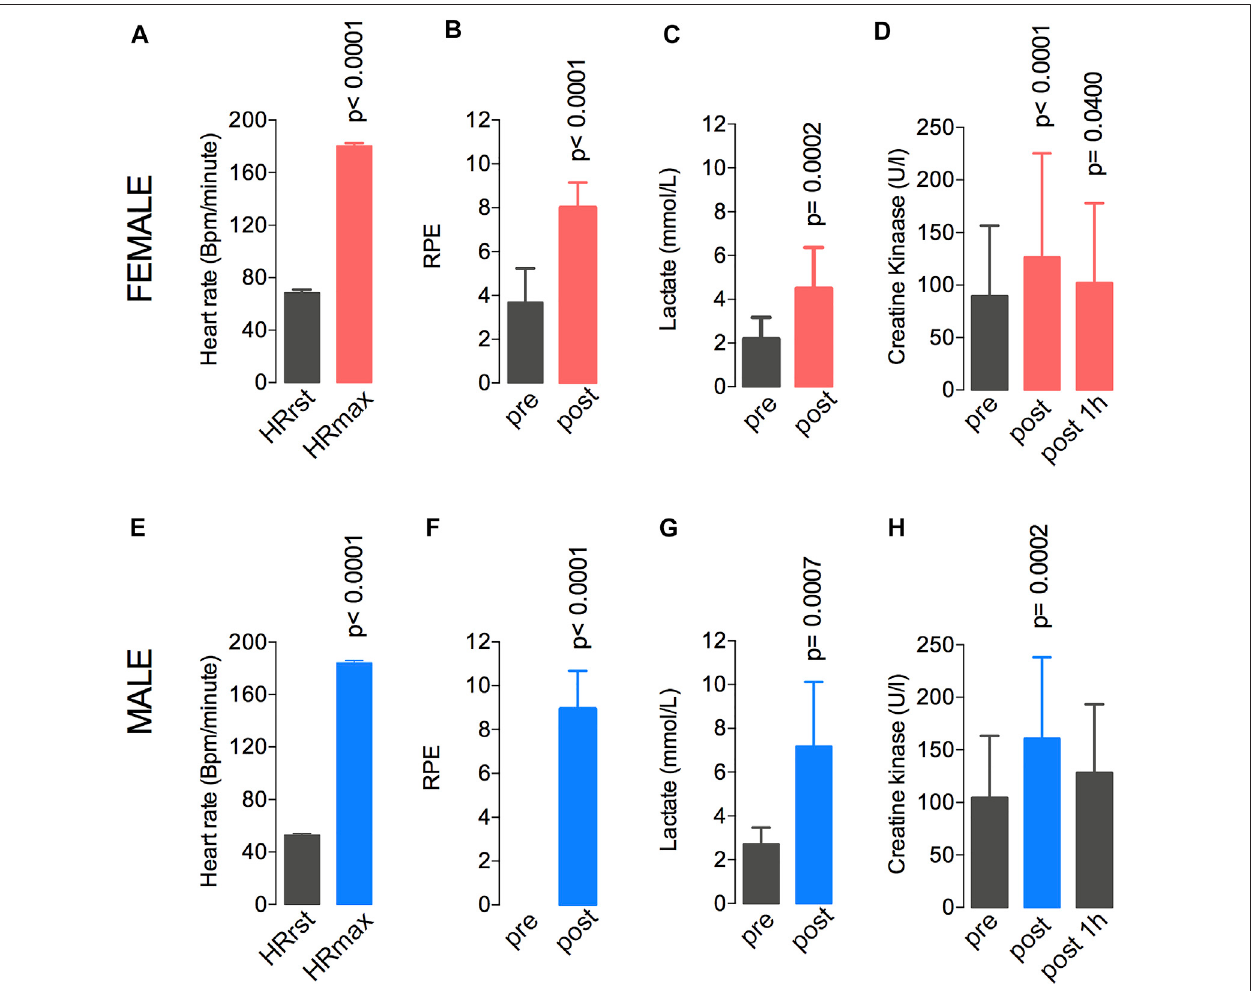
FIGURE2| Asinglesessionat77% – 80%oftheVO 2max resultedinelevatedheartrate (A,E) ,RPE (B,F) ,lactatelevels (C,G) ,andcreatinekinaselevels (D,H) inboth maleand female groups. Dataare shown asmeans and standard deviations, with p < 0.05 indicating statistical signi fi cance. p Difference between time-points. RPE, rate of perceived